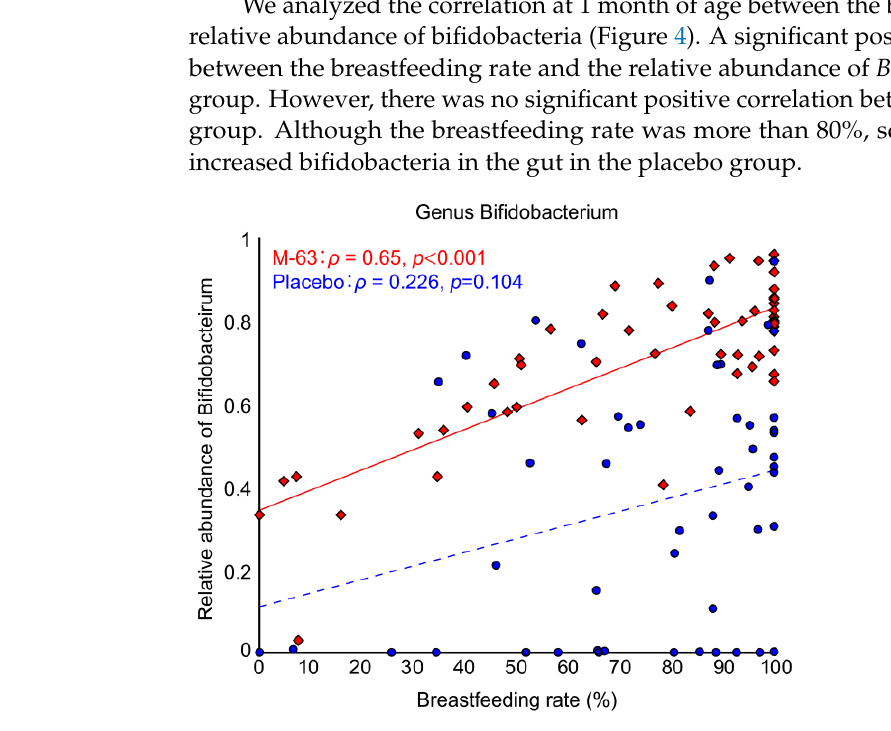
Figure 4. Correlation between the breastfeeding rate and the relative abundance of Bifidobacterium at 1 month of age. Red squares ( ◆ ) indicate the M-63 group, and blue circles ( ● ) indicate the placebo group. Spearman ’ s correlation coefficients and the corresponding p values are shown.